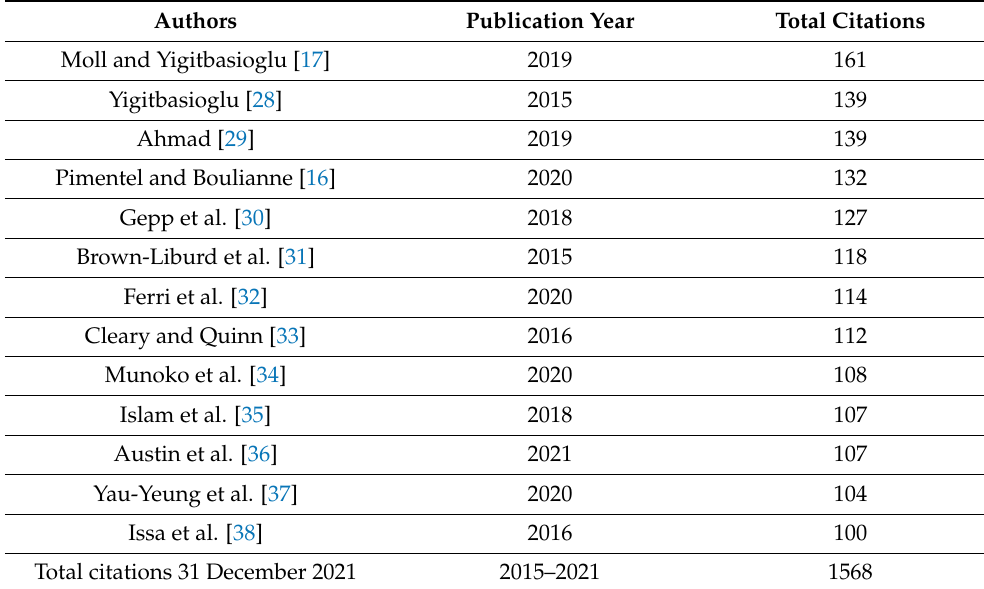
Table 2. Top articles by citations ranking places. (Source: authors’ creation).